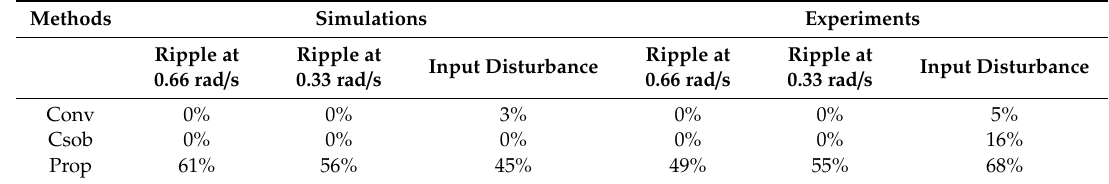
Table 7. Suppression percentage of Conv, Csob, and Prop methods compared to PI method with motor-side controller.